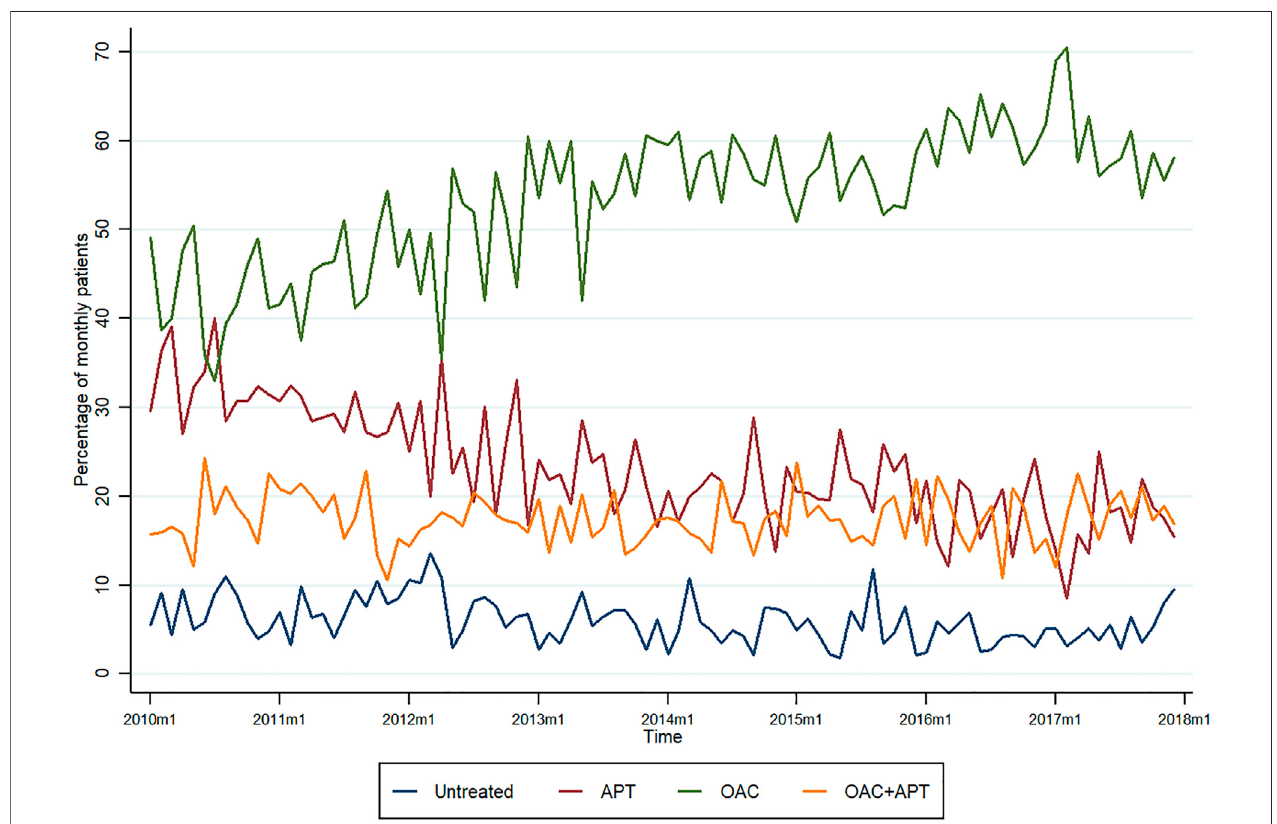
FIGURE 2 | Temporal trends of treatment strategies in stroke survivors with atrial fi brillation.